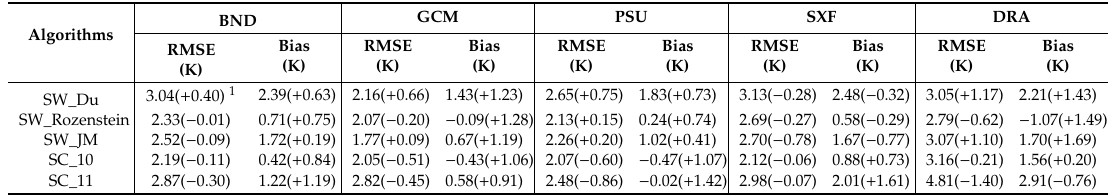
Table 7. The RMSE and Bias of the LST retrieved from Landsat 8 TIRS images on five sites after the stray light